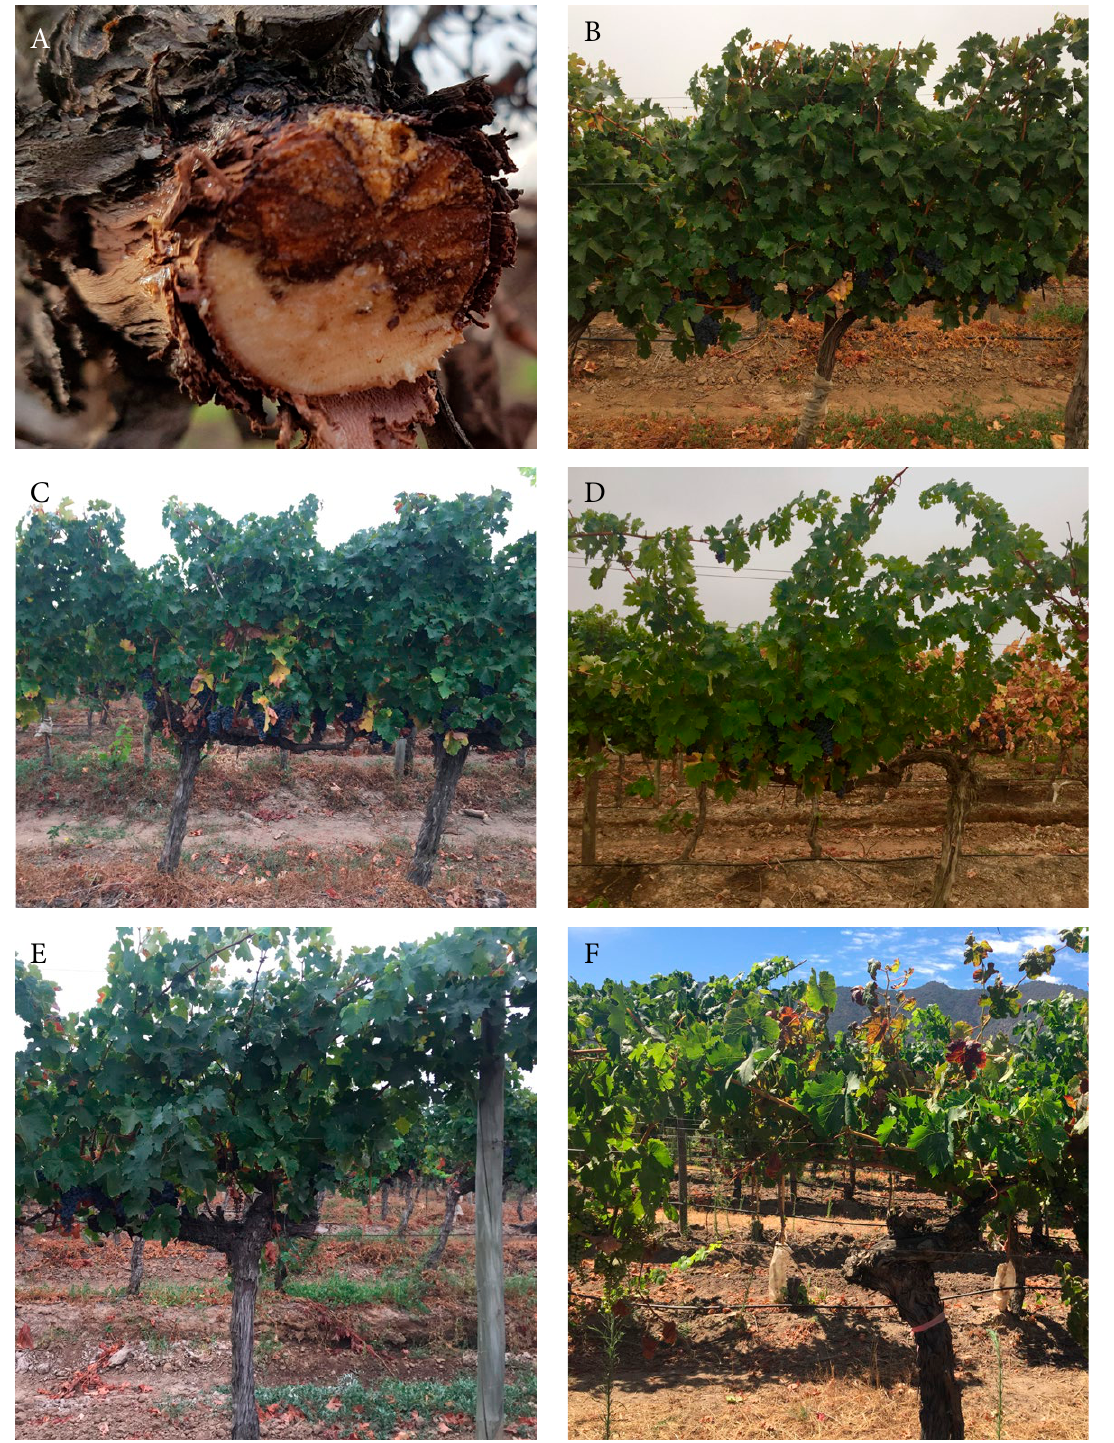
Figure 2. Damage and degrees of disease severity associated with dead arms in ‘Cabernet Sauvignon’ grapevines: A) Cross-section and old cordon, exhibiting double V-shaped dark brown necrosis; B) Severity score 0, healthy plant (both cordons complete and asymptomatic); C) Score 1, one asymptomatic cordon and one cordon with up to 50% of symptoms (one to three dead or missing spurs); D) Score 2, one asymptomatic cordon and an entire symptomatic cordon (four to six dead or missing spurs); E) Score 3, one symptomatic cordon and the second with up to 50% of symptoms and seven to nine dead or missing spurs; F) Score 4, dead plant (both cordons dead or totally